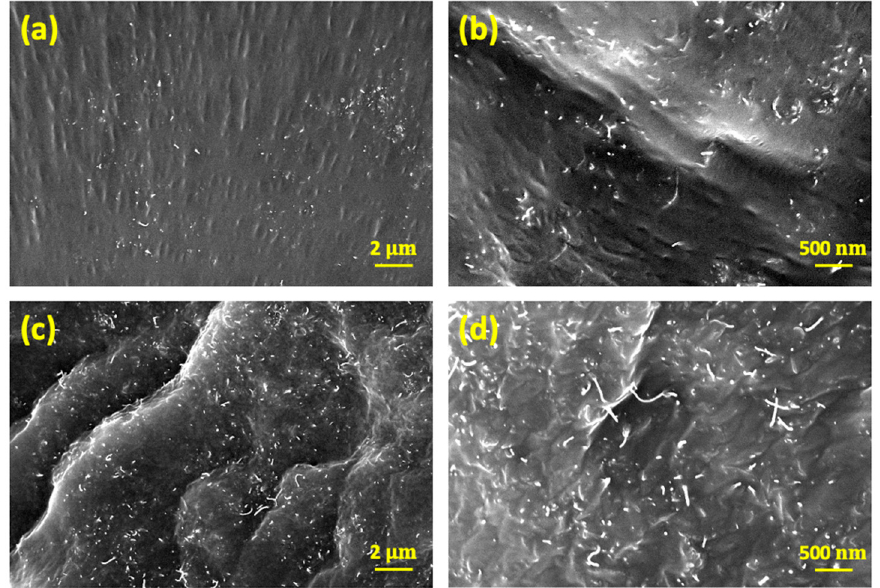
Figure 1. SEM images of composites ( a ) CNT/PDMS 1 wt% at low resolution, ( b ) CNT/PDMS 1 wt% at high resolution, ( c ) CNT/PDMS 5 wt% at low resolution, and ( d ) CNT/PDMS 5 wt% at high resolution.